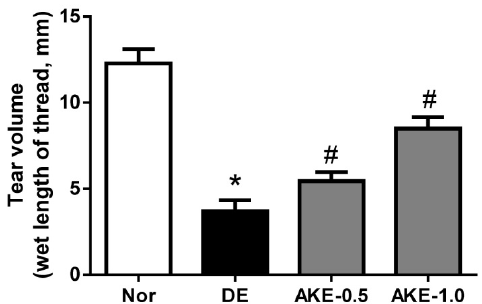
Figure 2. Effects of AKE on aqueous tear secretion. Tear volume was measured using the phenol red thread tear test. Tear volume was expressed in millimeters of thread that became wet by the tear and turned red in color. NOR: normal control mice, DE: vehicle ‐ treated dry eye mice, AKE ‐ 0.5: 0.5 mg/mL AKE ophthalmic solution ‐ treated DE mice, and AKE ‐ 1.0: 1 mg/mL AKE ophthalmic solution ‐ treated DE mice. The values in the bar graph represent the mean ± standard error (SE), n = 10. * p < 0.05 vs. normal mice, # p < 0.05 vs. vehicle ‐ treated dry eye mice.